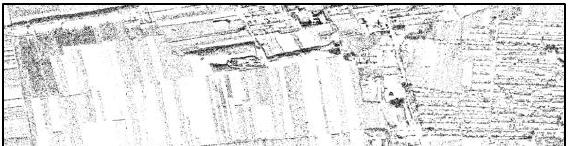
Figure 2. Automatic extracting result of reflecting symmetry sample.